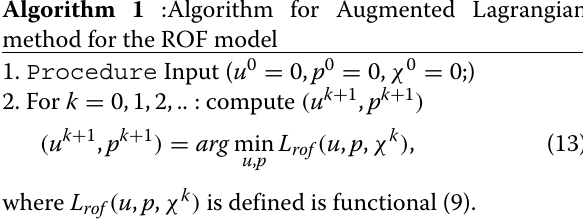
Algorithm 1 :Algorithm for Augmented Lagrangian method for the ROF